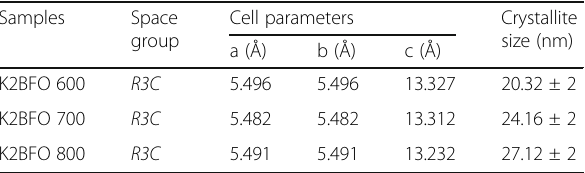
Table 1 Lattice parameters and the crystallite sizes for the